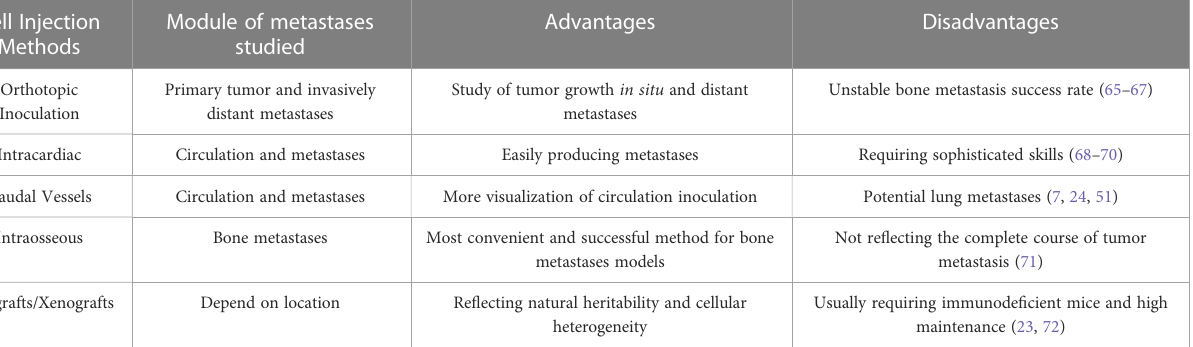
TABLE 2 Implantation methods for bone metastases